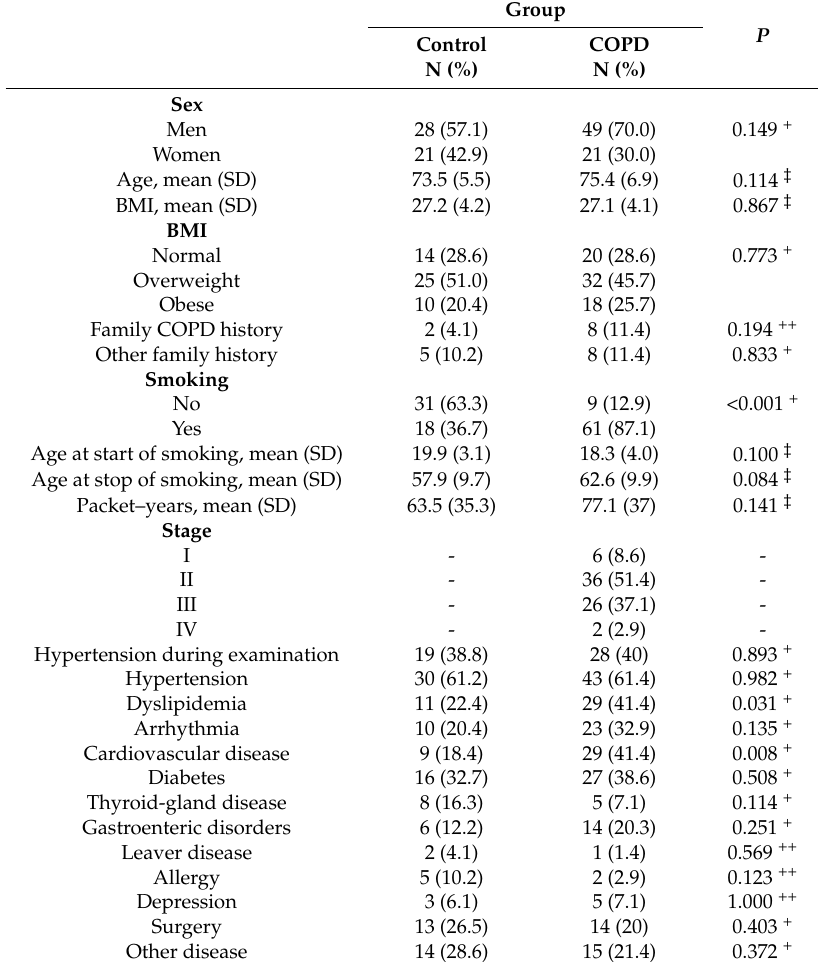
Table 1. Demographics and clinical characteristics of study participants (N =